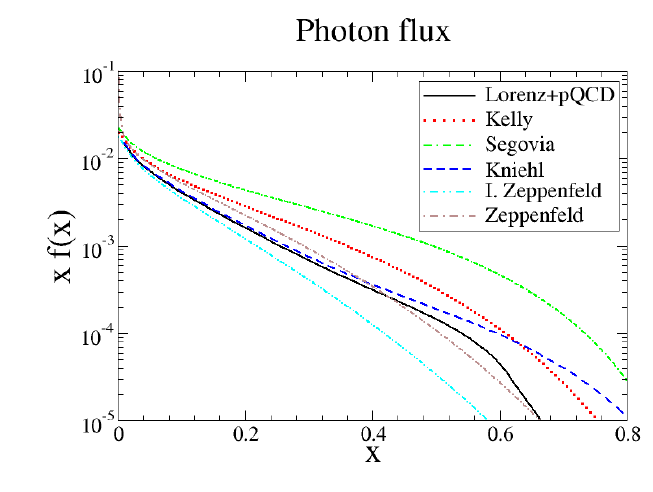
Figure 6 . Photon (cid:13)ux (multiplied by x ) against x to be used for elastic scattering (the proton exits the collision intact). Continuous black line: parametrization matching dispersion relations at low momentum and counting rules at high Q 2 . Dotted line (red online): the (cid:13)ux as computed by Drees and Zeppenfeld [58]. Dashed-dotted line (green online): improvement over this that includes the minimum Q 2 cuto(cid:11) [52]. Dashed line (blue online): (cid:13)ux factor of Kniehl [57] including both G E and G M